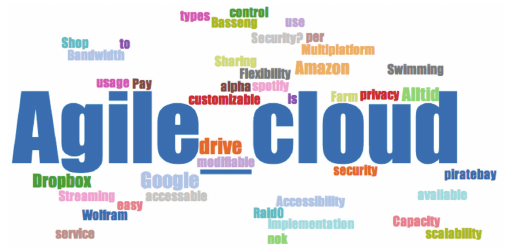
Figure 10: The results of the WordCloud session in lecture two.